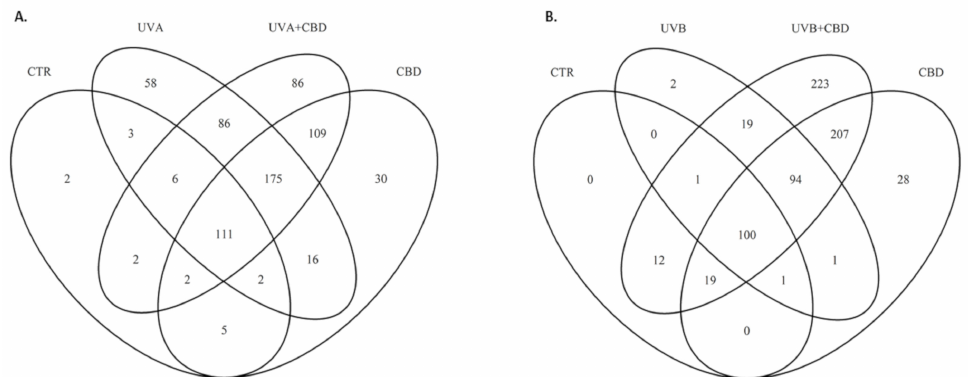
Figure 2. Venn diagram showing protein distribution in the keratinocytes cultured in a three- dimensional culture model and treated with cannabidiol (4 µ M) following UVA (30 J/cm 2 ) ( A ) or UVB (60 mJ/cm 2 ) ( B ) radiation. Data analyzed using RStudio (R version 3.6.2). The names and abundance of proteins are shown in Supplementary Table S1. Abbreviations: Ctr, control; CBD,